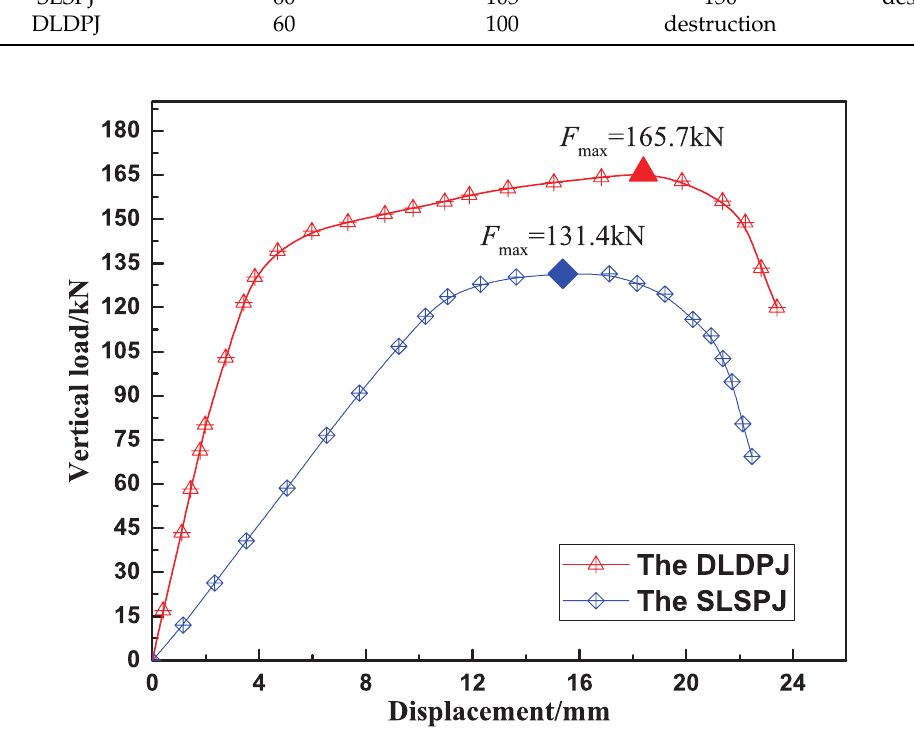
Figure 17. The load–displacement curve of tower bearing